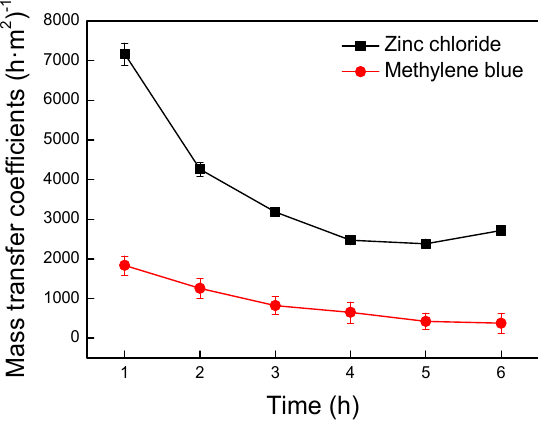
Figure 3. Effect of substance particle size on transmembrane mass transfer.